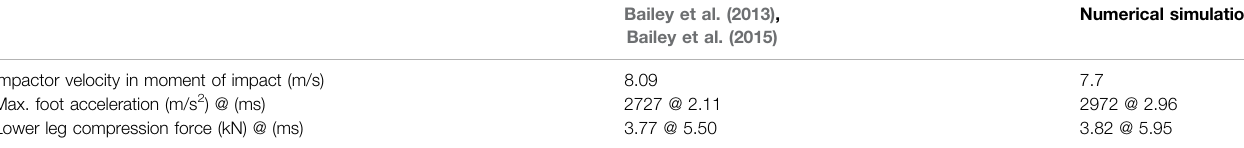
Bailey et al. (2013), Bailey et al. (2015)